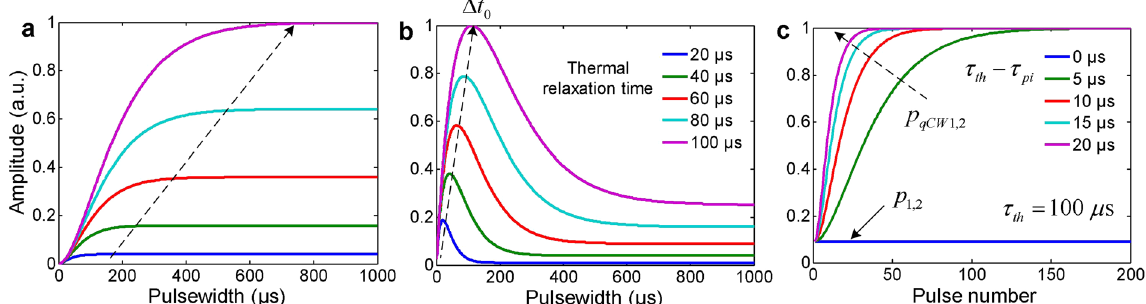
Figure 2. The simulation results of ( a,b ) The amplitude of the nonlinear PA incremental amplitude versus laser pulse width with different thermal relaxation time under case 1 and case 2. The dotted arrow line indicates the laser pulse width when the maximum LDPA amplitude is achieved. ( c ) The amplitude of the nonlinear PA amplitude versus laser pulse number with different pulse-pulse intervals (thus different τ th − τ pi ) under case 3 with constant thermal relaxation time 100 µ